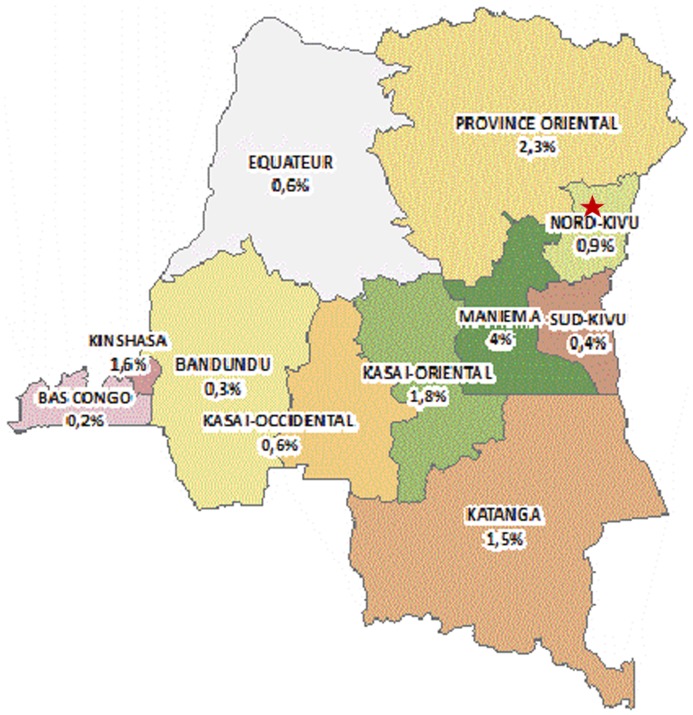
Map of the Democratic Republic of Congo with provincial HIV prevalence.